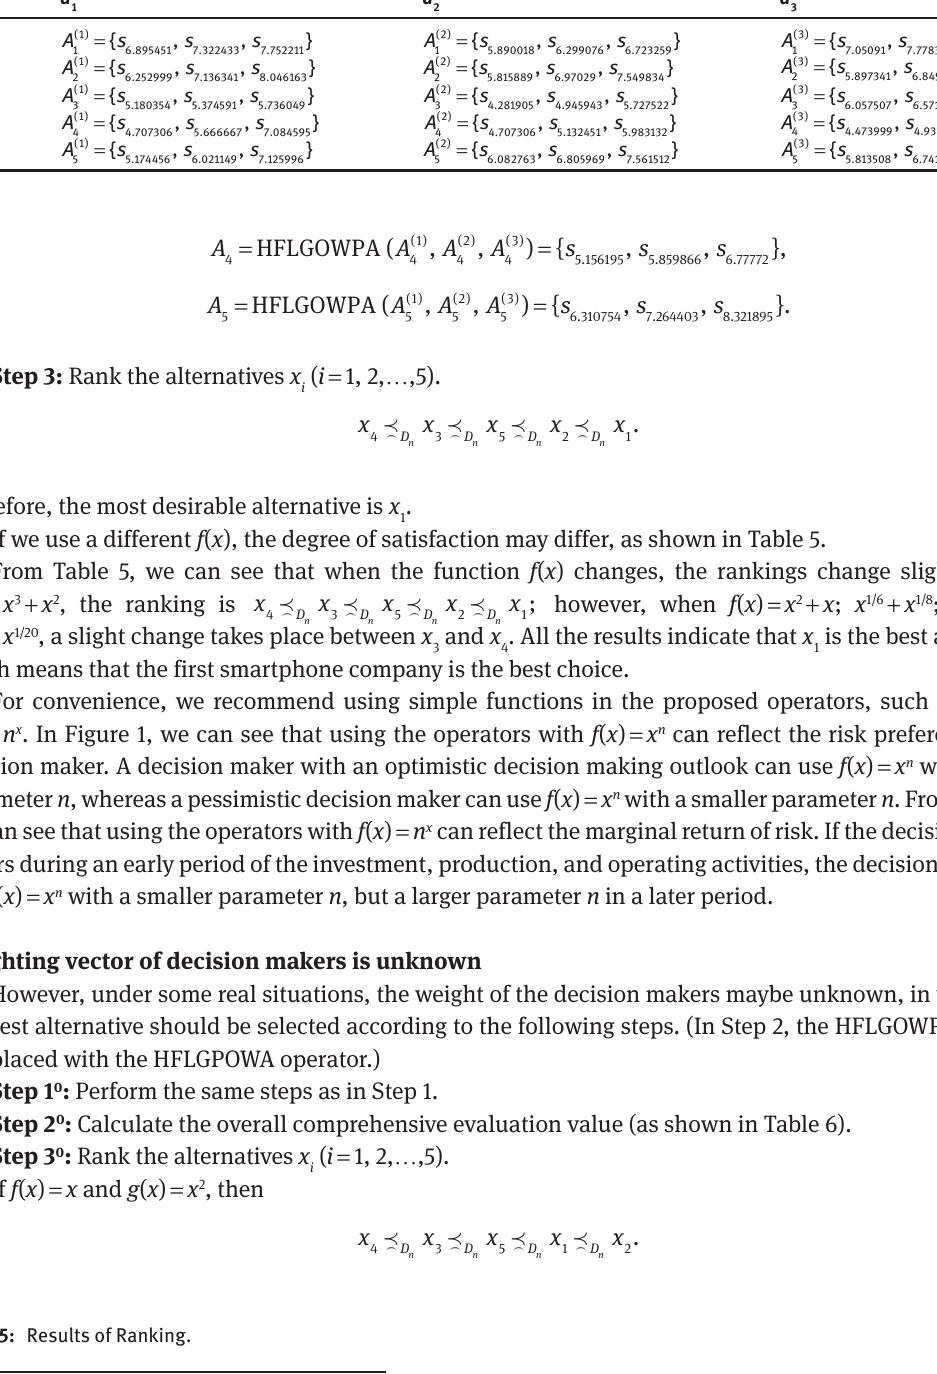
Table 4: Comprehensive Evaluations of the Alternatives. d